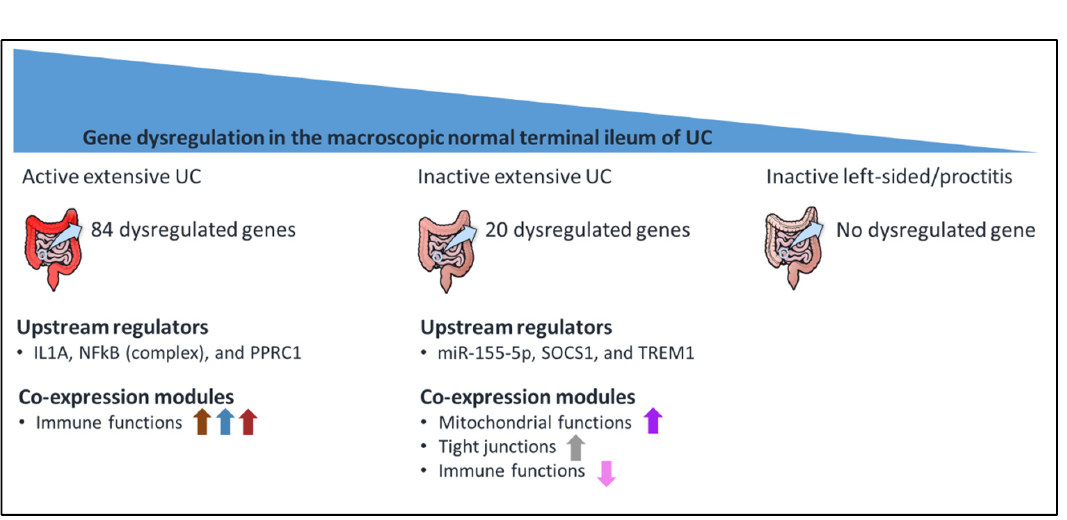
Figure 3. Schematic summary of the current study. Ileal expression from ulcerative colitis (UC) patients is dependent on UC disease activity and extent. The strongest dysregulations were seen in patients with extensive disease as maximal disease extent during follow-up. Co-expression module analysis found that ileal changes in active extensive UC are mainly related to the immune function (colour code for identified co-expression modules: saddlebrown, steelblue, and brown). Ileal changes in inactive UC, on the other hand, seem to be functioning to maintain the intestinal barrier with increased mitochondrial functions (colour code for identified co-expression modules: purple and grey60) and dampened immune functions (colour code for identified co-expression module: violet).